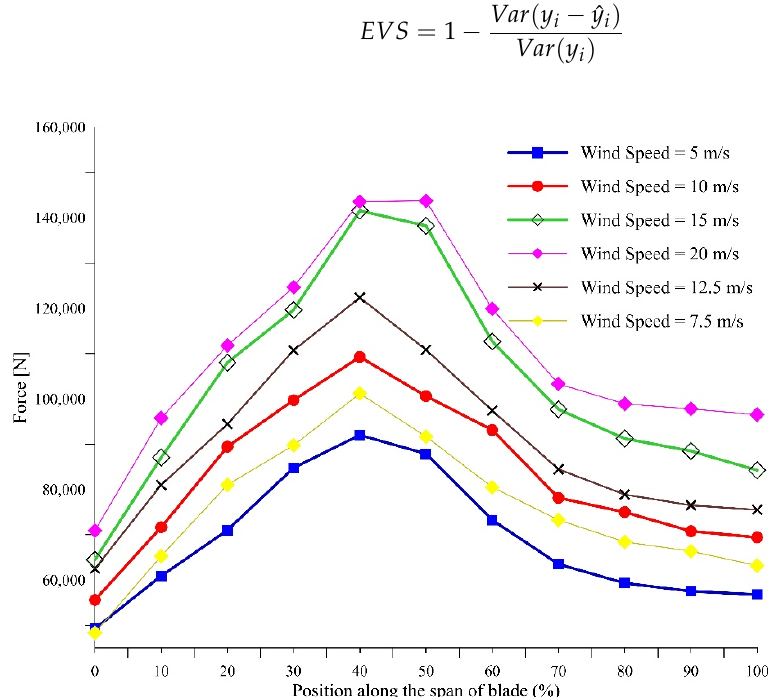
Figure 11. Axial force distribution along the span at the centerline of span for 4 ◦ at various wind speeds.